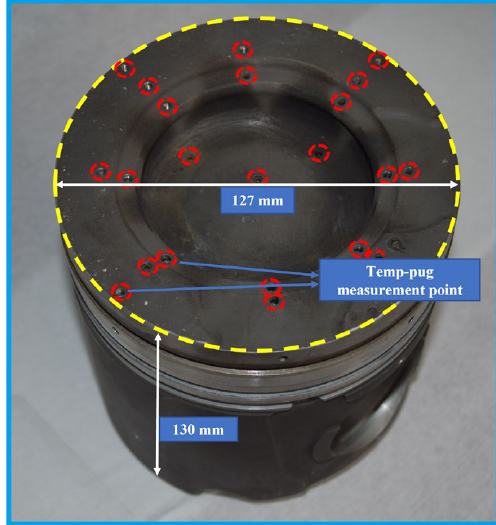
Figure 2. The piston in this study.